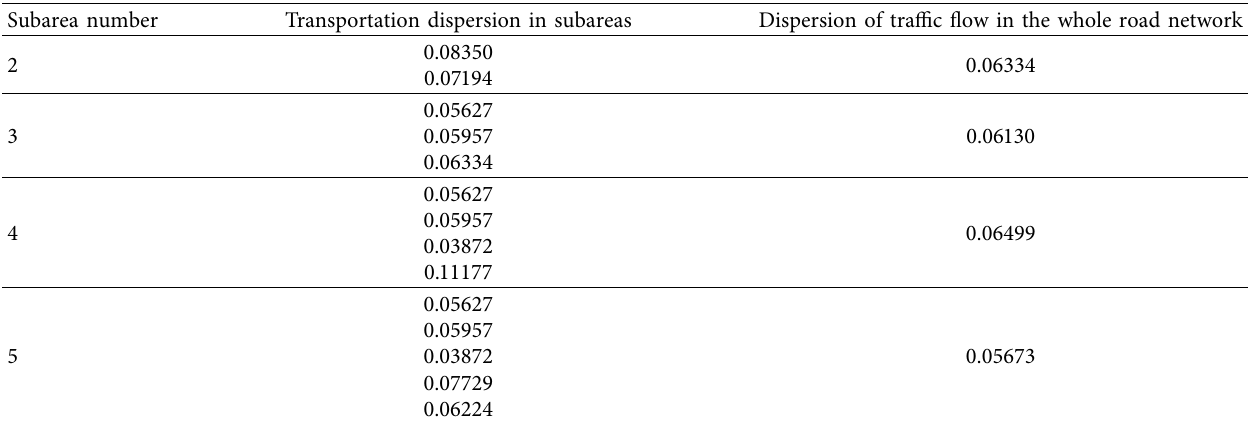
Table 1: Dispersion of traffic flow of each scheme.